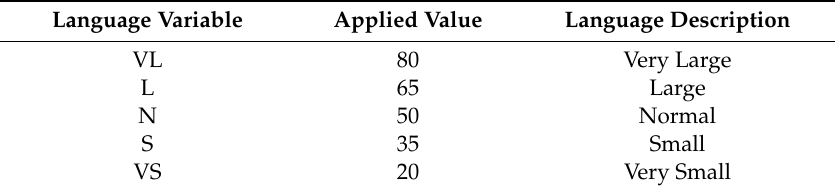
Table 3. Definition of the language variable for the SOC of a battery